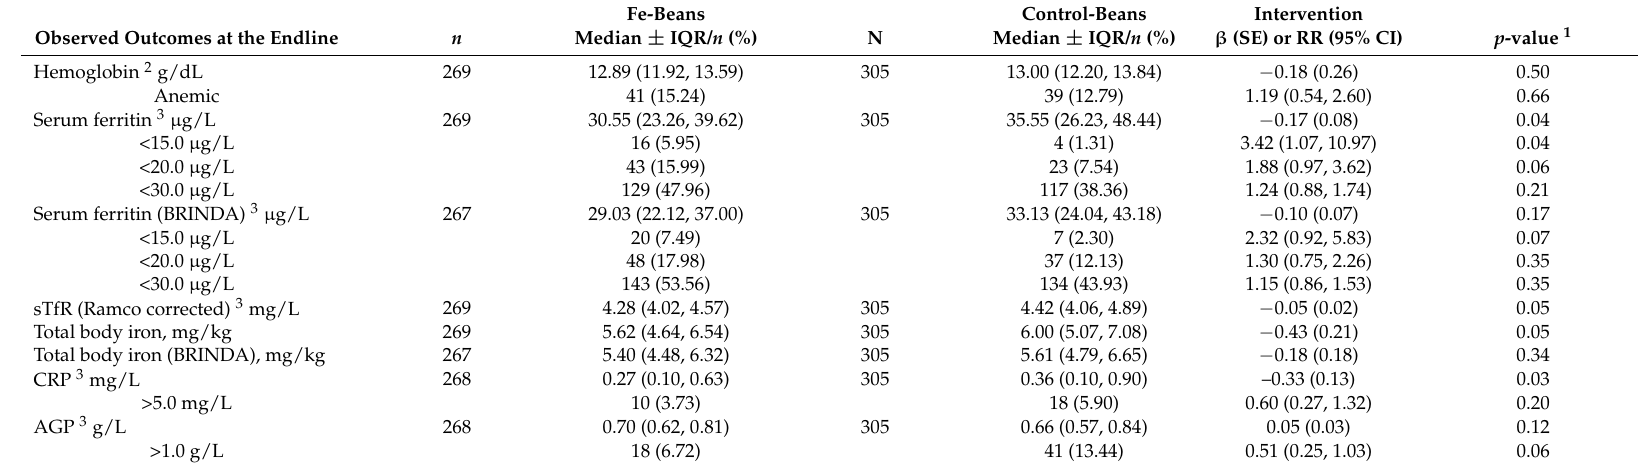
Table 2. Effects of consuming iron-biofortified bean on the iron status in children, compared to control beans ( n = 574).